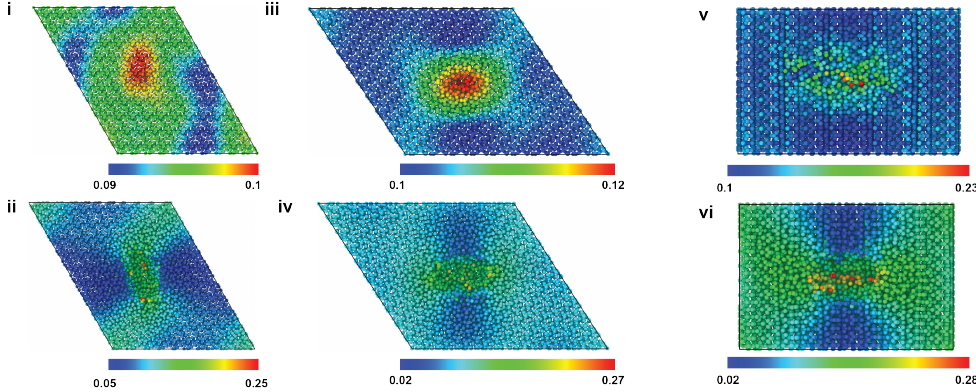
Figure 5. Atomic snapshots of HAP models at the inception of compressive failure for 7.5 Å (top row) and 30 Å (bottom row) pores, for X ( i , ii ), Y ( iii , iv ), and Z ( v , vi ) loading. Atoms are colored according to the von Mises shear strain. The view of the snapshots for X and Y loading is the X-Y plane, and it is the Y-Z plane for the Z loading.